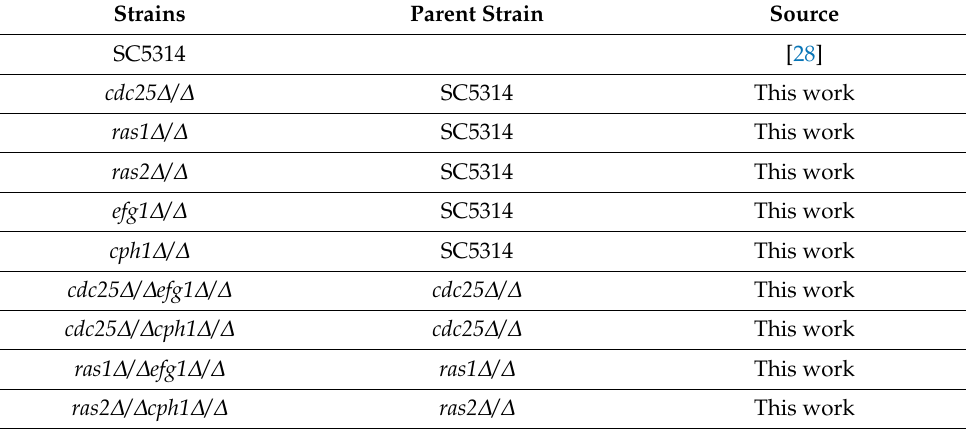
Table 1. C. albicans strains used in this